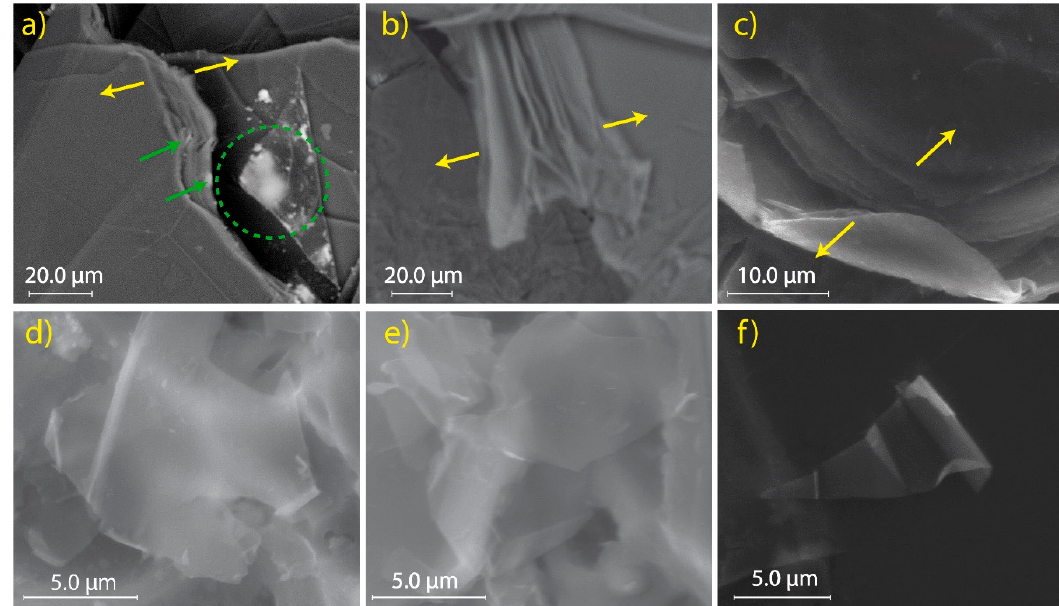
Figure 2. Scanning electron microscopy (SEM) morphology of pretreated natural graphite in ( a ) 1.0 mg mL − 1 , ( b ) 0.5 mg mL − 1 , and ( c ) 0.1 mg mL − 1 of CTAB aqueous solution. ( d – f ) Semitransparent layers obtained from supernatant after 2000 rpm centrifugation for 90 min, subject to 3 h of sonication in the three different CTAB concentrations.